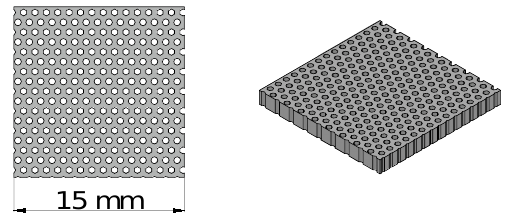
Figure 9. Three-dimensional drawing of the printed sample at 68% filling. Table 4. Lattice characteristics of the